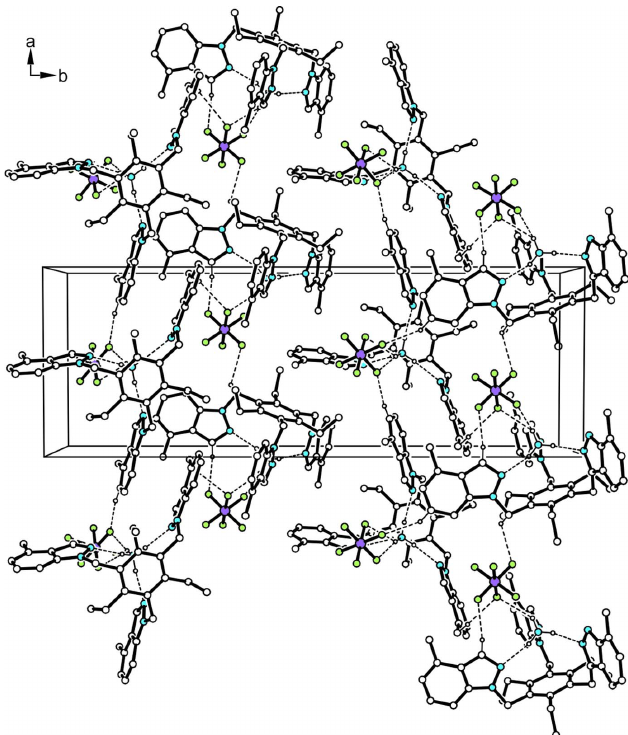
Figure 3 Packing excerpt of the title complex viewed down the crystallographic c - axis. For the sake of clarity, hydrogen atoms of the receptor not involved in hydrogen bonding are